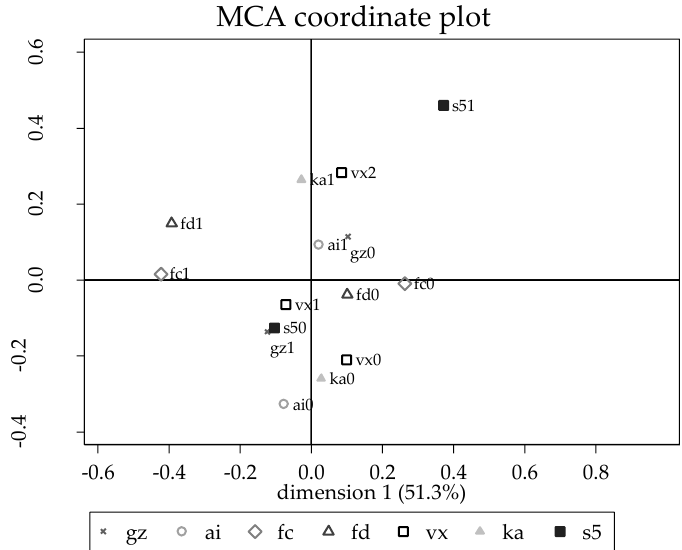
Figure 2. Multiple correspondence analysis (MCA) plot for the factors associated with the high seroprevalence site. Gz = grazing, where gz0 is zero-grazing and gz1 is grazing. Ai = artificial insemination, where ai0 is no artificial insemination and ai1 is use of artificial insemination. Fc = floor cleanliness, where fc0 is clean or moderately clean floor and fc1 is dirty floor. Fd = drainage, where fd0 equals insufficient drainage and fd1 is good drainage. Vx = vaccination, where vx0 means no vaccination done, vx1 means vaccination when there is an outbreak or when given free vaccines, and vx2 means vaccinating animals as young. Ka = knowledge about antibiotics, where ka0 is no knowledge and ka1 is the farmer reporting to know about antibiotics. S5 = site Guwahati, where s50 means any other site and s51 means Guwahati.